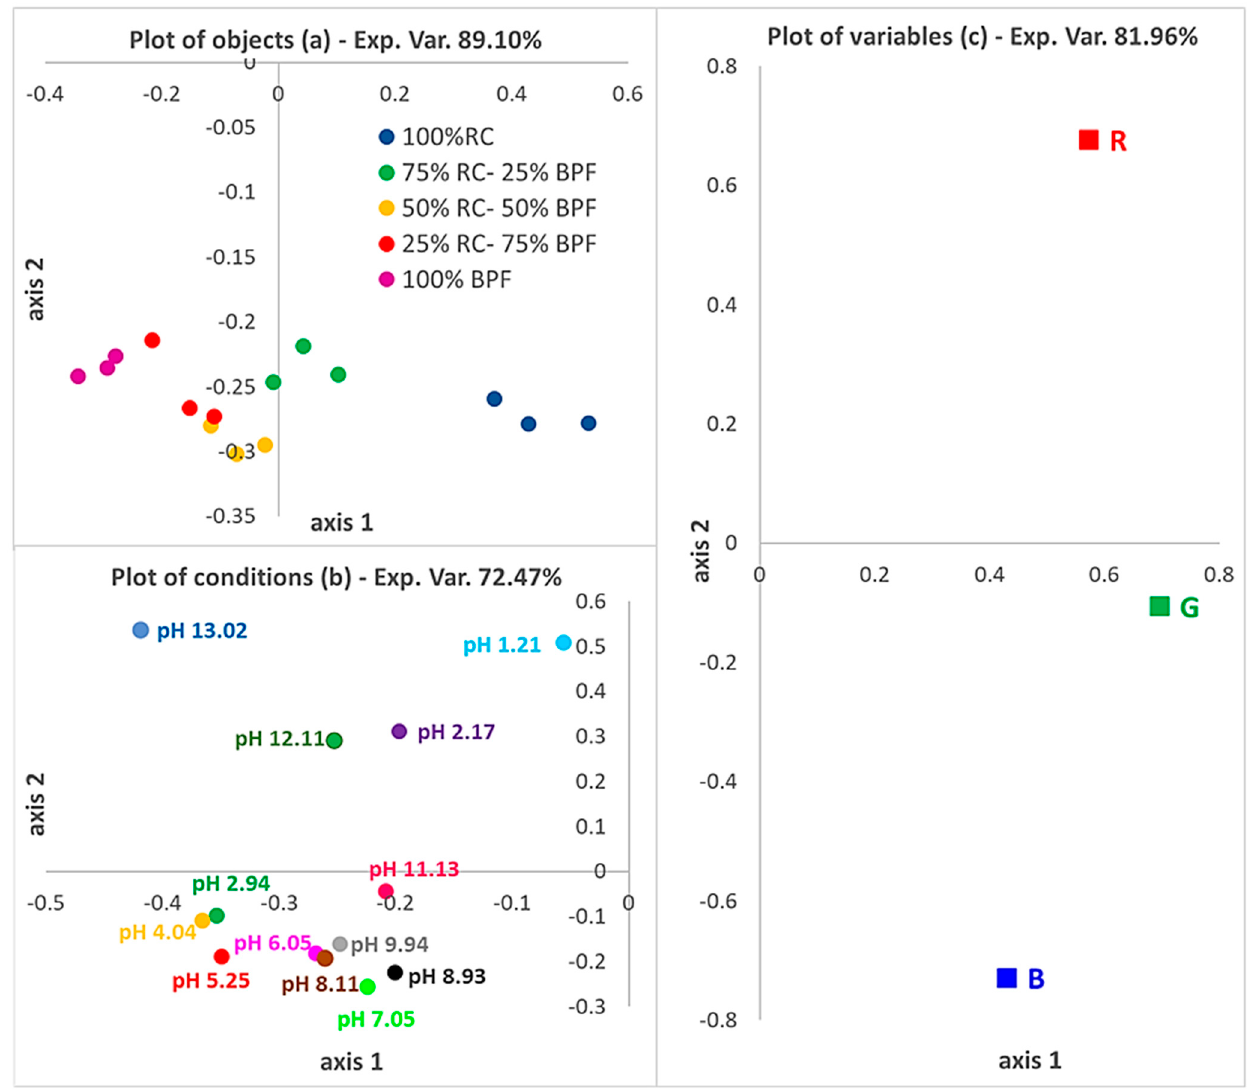
Figure 4. The loading plots of the 3 − Way PCA model on the first two axes: Plot of the objects ( a ), Plot of conditions ( b ) and Plot of variables ( c ). Exp. Var. = cumulative % variance explained after unfolding.